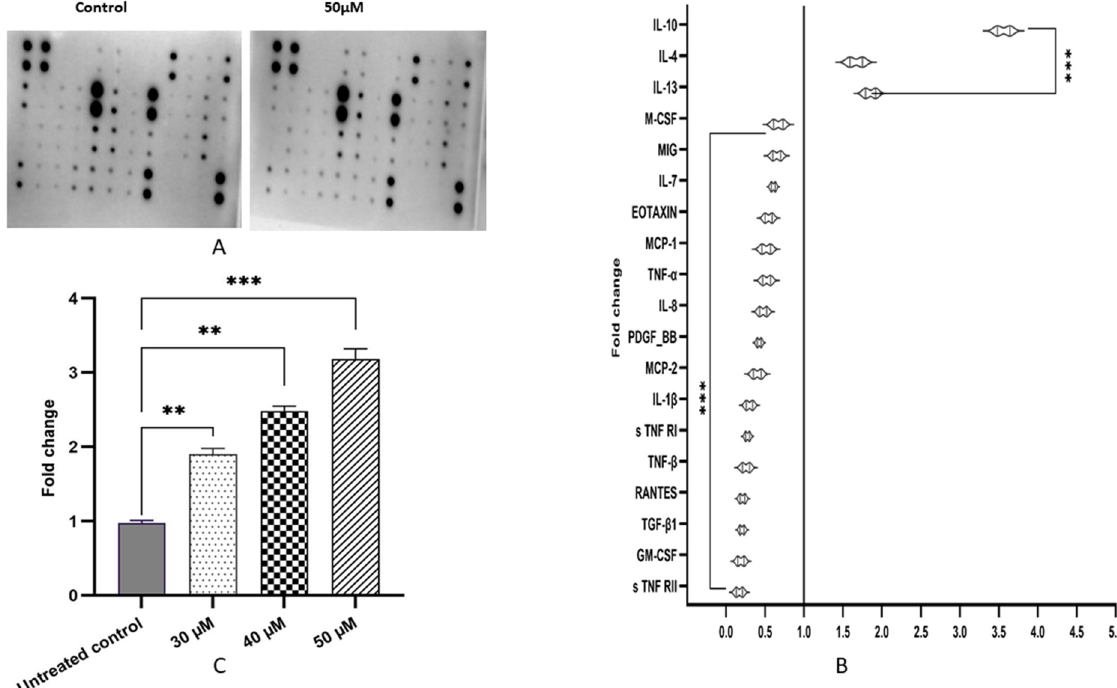
Figure 5. ( A ) Differential protein expression of inflammatory cytokines ( A ) Images of nitrocellulose membrane demonstrating differential expression ( B ) Graph representing reduced expression of pro- inflammatory and chemokines, whereas anti-inflammatory cytokines expression was increased in kaempferol-treated (50 µM) cells compared to DMSO control. ( C ) Graph showing an increase in total glutathione level in kaempferol-treated HeLa cells at 30, 40 and 50 µM for 48 h. Data are presented as the mean ± standard deviation of three independent experiments. Two way-ANOVA*= p < 0.05; ** = p < 0.01, *** p < 0.001.